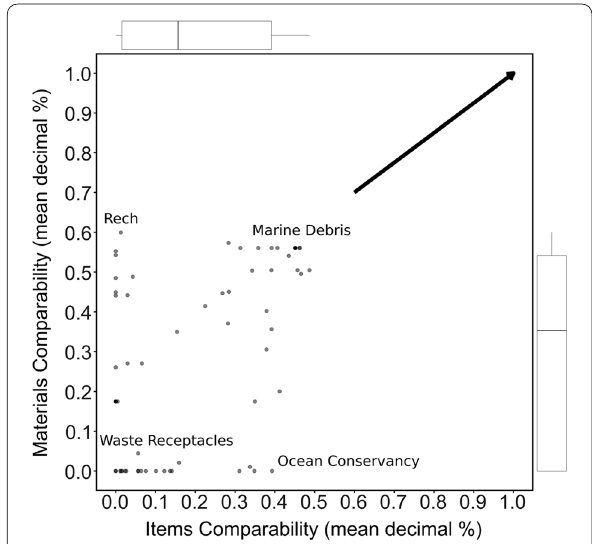
Fig. 4 Average comparability for each survey list by item classes and material classes. The proportion represented the average percentage of classes in other lists that the list plotted has. The x axis is the average comparability of the item classes, and the y axis is the average comparability of the material classes—an arrow points toward where we aim for survey comparability to go in the future. Marginal boxplots on the top and right axes show the boxplots for the x and y axis, respectively. Full list of comparability metrics for all survey lists is in the SI (Table